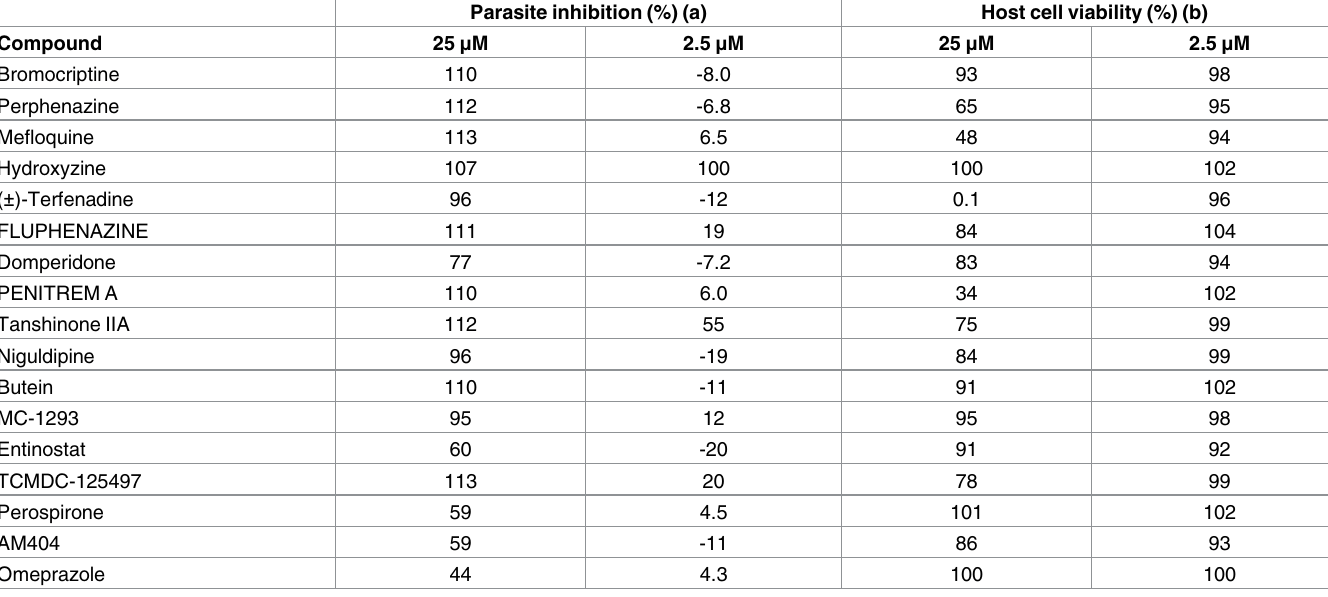
Table 2. Effects of hit compounds on RH-2F tachyzoites and HFF cells.